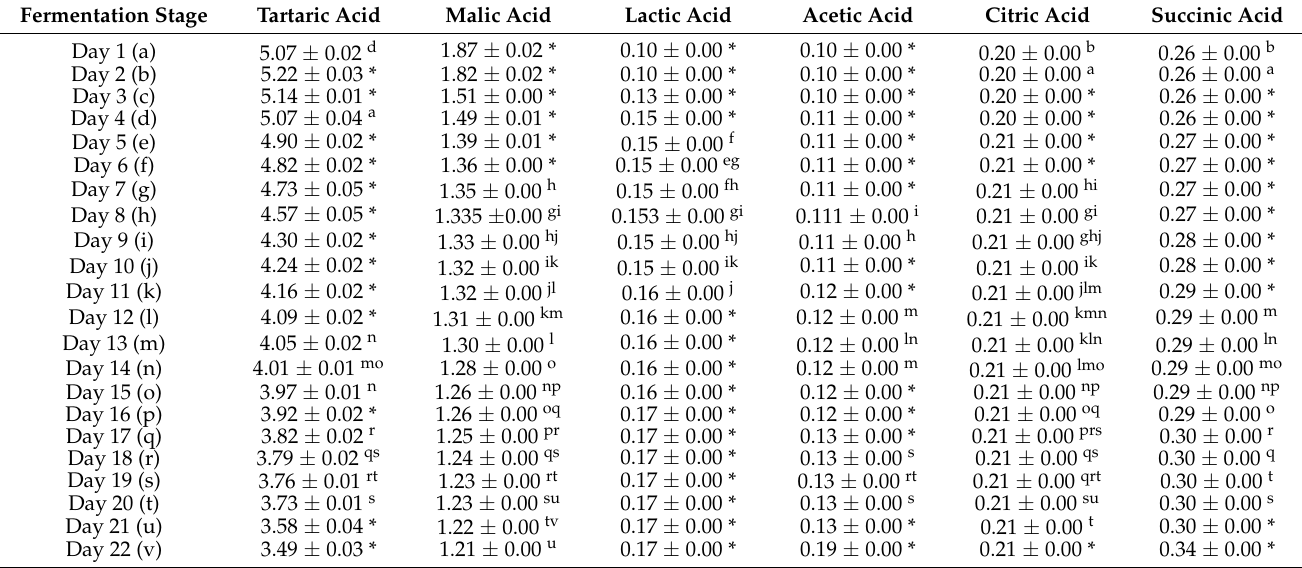
Table 5. Evolution of main organic acids during alcoholic fermentation of V4 variant